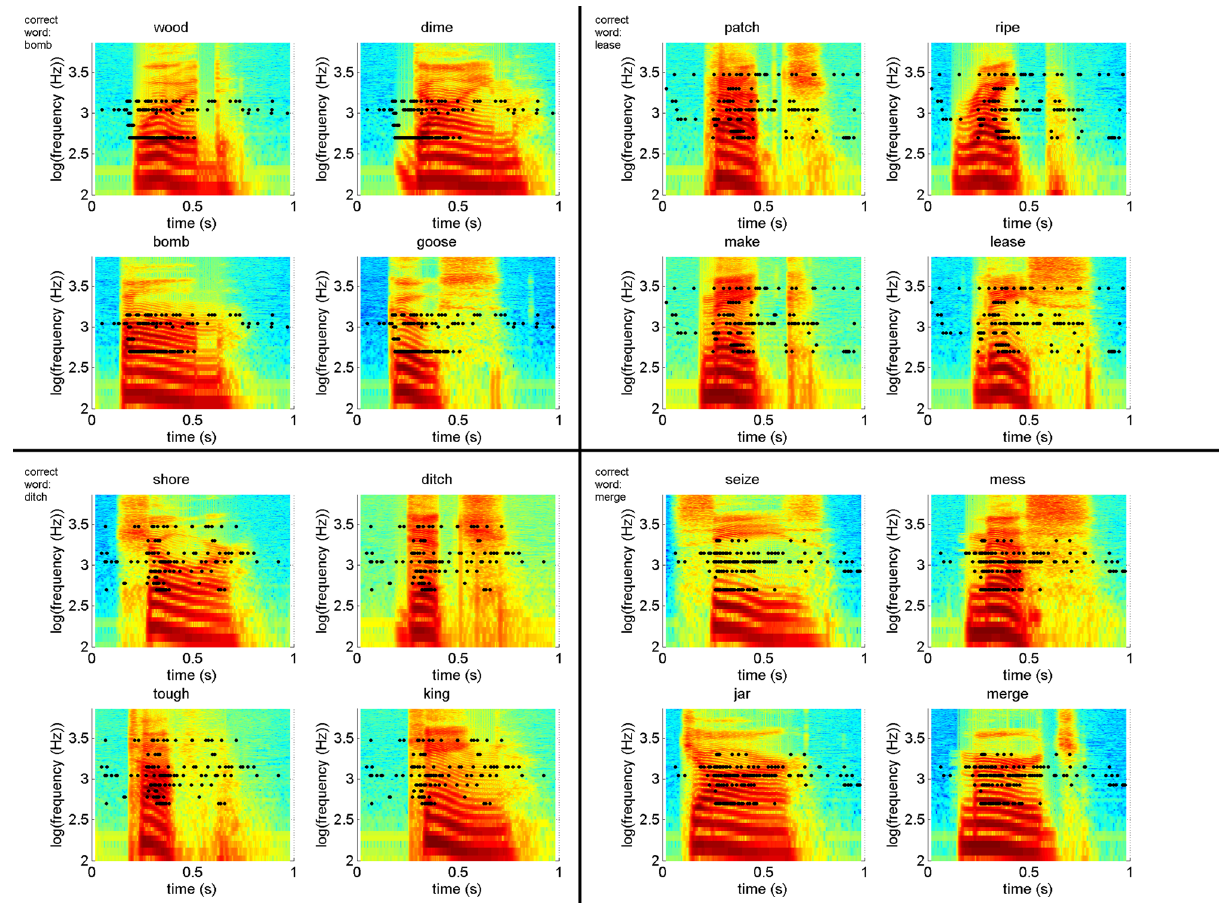
Figure 5. The 16 panels show the spectrogram of four sets of four words. The correct word is given at the left upper corner of each 2 × 2 set of words. On average, the words on the left (bomb and ditch) were identified correctly in over 50% of the cases, the two words on the right (lease and merge) were identified in less than 10% correctly. The raster plots for the correct word overlay each spectrogram in one set. Each black dot indicates the timing when a pulse is delivered. The spectrogram and electrodogram can be directly compared. From the figure, it is obvious that the frequencies and the timing are poorly matched. It is also clear from the electrodogram that the test person had cues from intensity patterns or length of the stimulation. The electrodograms also show that either an artificial code or a better-distributed pulse pattern is required to improve performance.